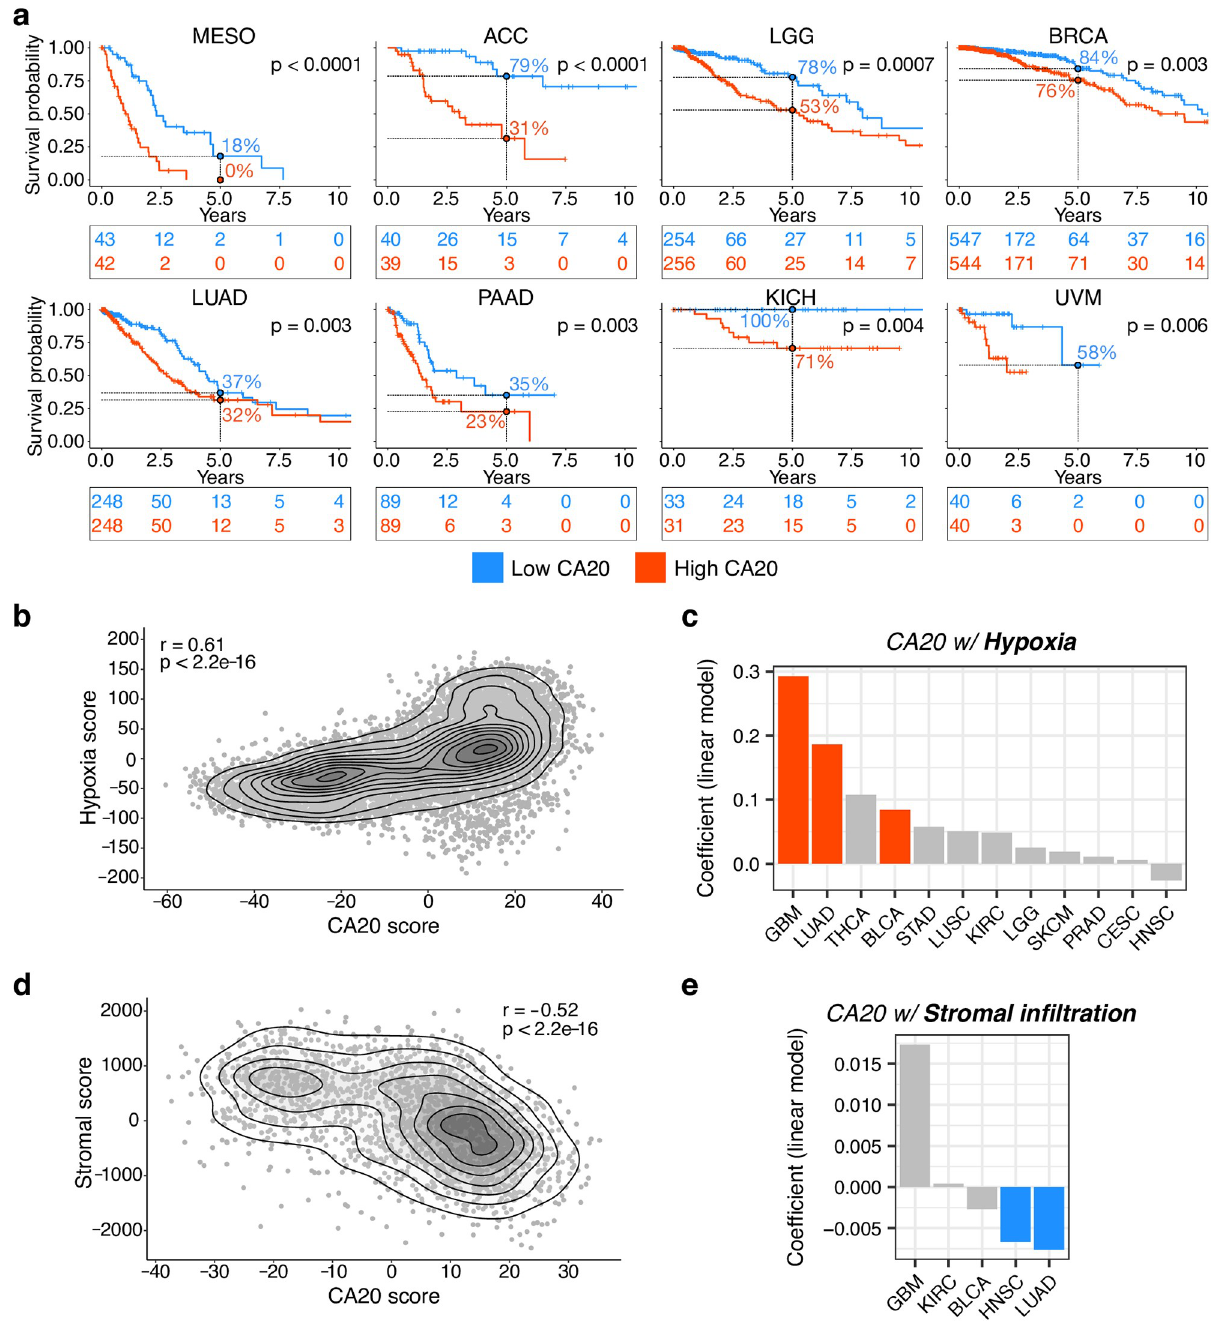
Fig 5. High CA20 is associated with poor patient prognosis, hypoxia and lower stromal infiltration in cancer. ( a ) Kaplan-Meier plots for patient stratification based on CA20 score (patients divided by CA20 median: lower CA20 in blue and higher CA20 in red) in 8 different cancer types. Numbers at risk every 2.5 years (tables) and 5-year survival rates (points and dashed lines) are shown. P-values for log-rank tests for differences in survival are shown. ( b ) CA20 upregulation is associated with hypoxia. Smooth scatter plot showing correlation between the hypoxia and the CA20 scores across TCGA tumour samples (Spearman’s correlation coefficient, r = 0.61, p-value < 2.2e-16). ( c ) CA20 upregulation is associated with hypoxia in different cancer types. Linear regression coefficients, representing the CA20 score dependence on hypoxia score, independently of genomic instability, across the TCGA cohorts with information for all covariates. Significant associations (FDR < 0.05) are coloured. ( d ) CA20 is associated with lower stromal cell infiltration. Smooth scatter plot showing correlation between the CA20 and the stromal scores across TCGA tumour samples (Spearman’s correlation coefficient, r = -0.52, p-value < 2.2e-16). ( e ) CA20 is associated with lower stromal cell infiltration in head and neck squamous cell carcinoma and lung adenocarcinoma. Linear regression coefficients, representing the CA20 score dependence on stromal score, independently of genomic instability,